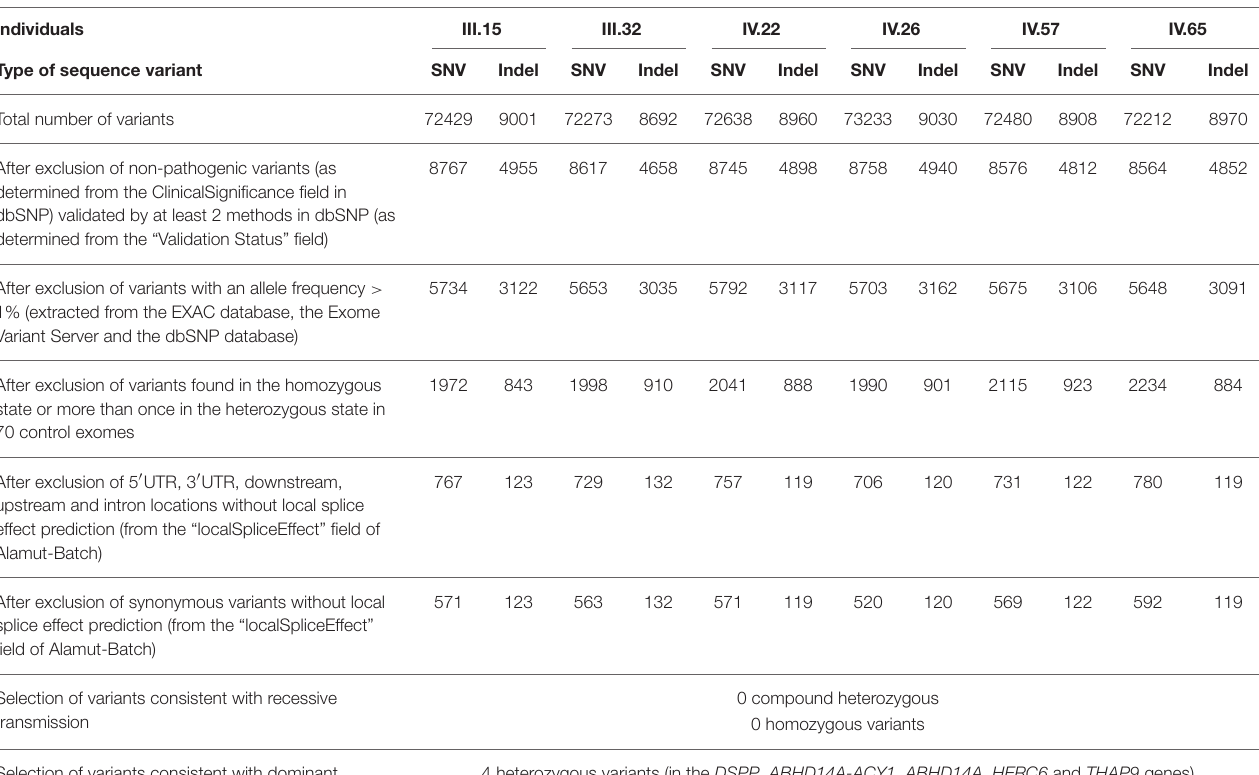
TABLE 1 | Summary of the exome sequencing